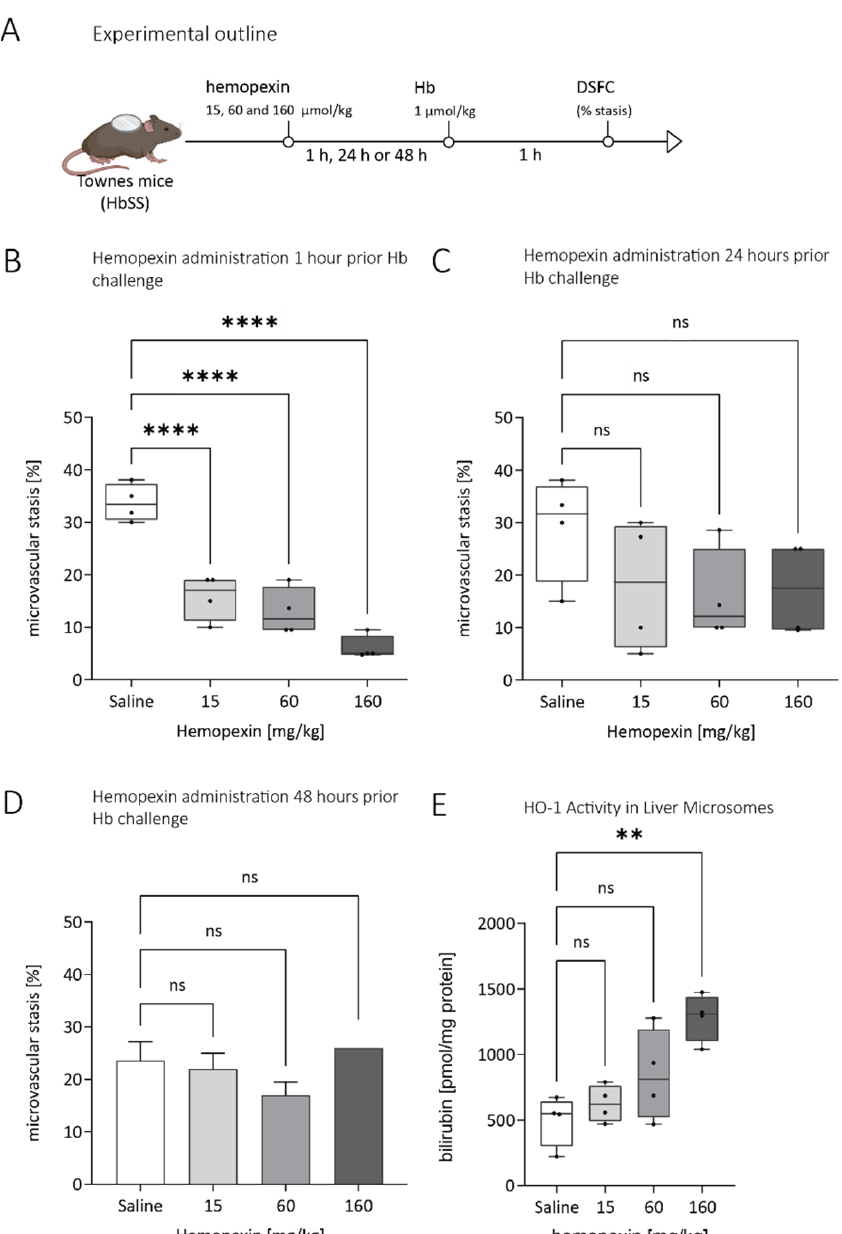
Figure 2. Dose range and durability of hemopexin effect administered at different times before hemoglobin triggered VOC. Dorsal skin-fold chambers were implanted onto Townes HbSS mice, and 20–24 flowing venules were selected in each mouse at baseline (time 0). ( A ) Prophylactic experimental setup: HbSS mice were infused with hemopexin (15, 60 and 60 mg/kg) or saline vehicle at baseline after selection of flowing venules. Hemoglobin (Hb, 1 µmol/kg) was infused 1, 24, or 48 h after hemopexin administration and microvascular stasis (% non-flowing venules) was measured in the same venules 1 h after Hb infusion. ( B ) Stasis data where hemopexin was administered 1h before Hb challenge ( n = 4/group), ( C ) 24 h before Hb challenge ( n = 4/group) and ( D ) 48 h ( n = 2/group) before Hb challenge ( E ) Hemopexin treatment indicates a trend to increased HO-1 activity. Livers from HbSS mice treated with hemopexin and challenged after 1 h with Hb (1 µmol/kg) were removed and flash frozen 4 h after Hb infusion. Hepatic microsomes were used to assess HO-1 activity via bilirubin production. Box and whiskers plots represent means ± Min to Max. ** p < 0.01, **** p < 0.0001 versus HbSS (saline treated). ns = not significant.